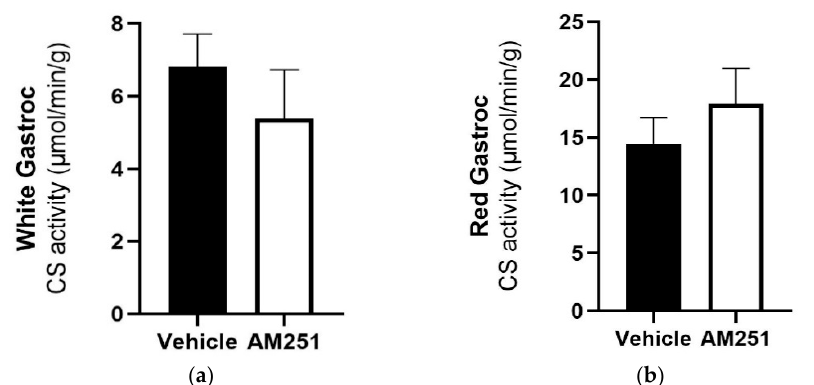
Figure 2. The effect of chronic AM251 treatment on citrate synthase activity in red and white gastrocnemius skeletal muscle in HFD rats. HFD rats were injected daily with either AM251 (3 mg/kg of body weight, ip) or vehicle for six weeks. ( a ) Red gastrocnemius (n = 9) and ( b ) White Gastrocnemius (n = 9) citrate synthase activity following treatment with AM251 compared to vehicle treated rats. Table 3. The effects of AM251 and acute adiponectin treatment on skeletal muscle gene expression in HFD rats. The soleus and EDL were obtained from HFD rats treated with vehicle or AM251 for 6 weeks and exposed ex vivo to 0.1 µ g/mL of adiponectin (n = 7–9) or adiponectin vehicle (n = 6–9) for 30 min. All data are presented as a mean ± SEM in arbitrary units (normalized to housekeeping genes, GAPDH, cyclophilin and β